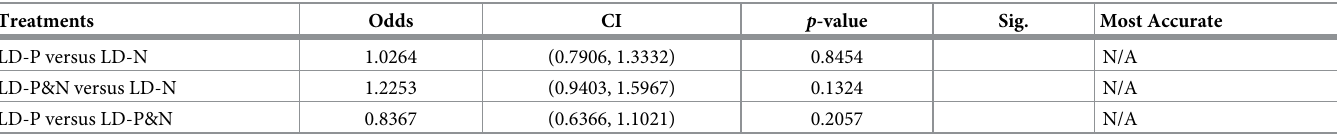
Table 11. LD : Set cardinality accuracy analysis.